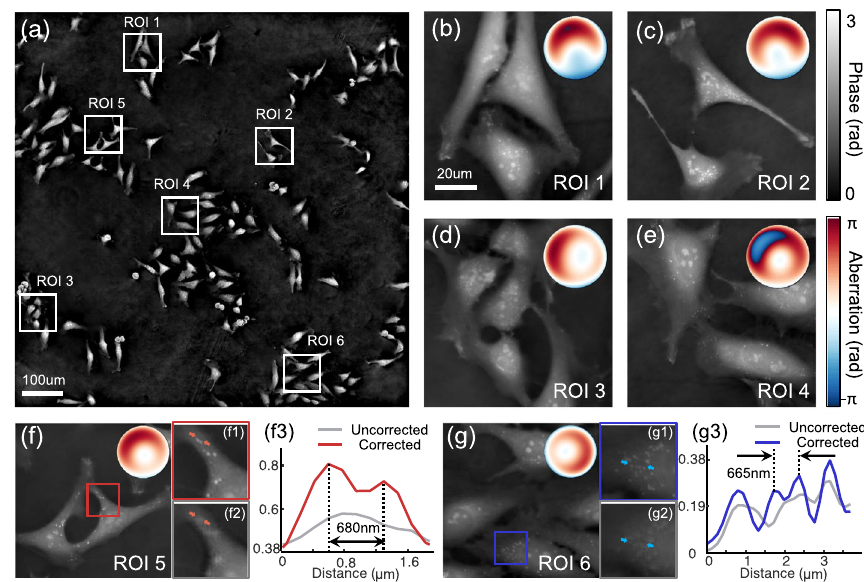
Fig. 4 Full-FOV high-resolution reconstruction of living HeLa cultures based on AO-QPI. (a) Reconstructed full-FOV phase map. (b-g) Zoomed view of the reconstructed cell phase in 6 regions as well as the recovered aberrations. (f1)-(f2) (g1)-(g2)Comparison of recovered phase maps with and without aberration correction in red and blue boxes of (f) and (g). (f3) (g3) Profiles of the cell phase in (f1)-(f2) and